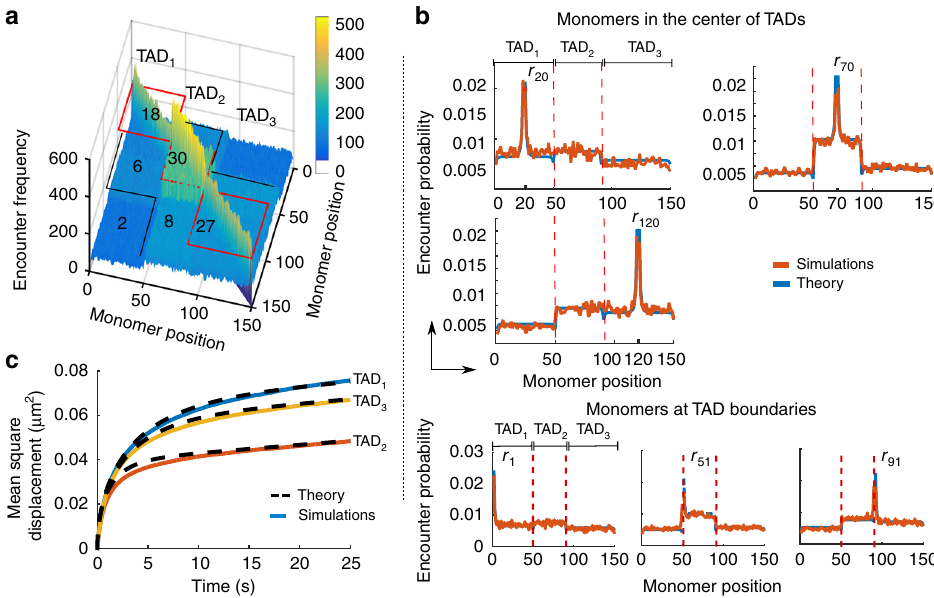
Fig. 1 Statistical properties of the heterogeneous RCL polymer. a Encounter frequency matrix of a polymer with three TAD blocks (TAD 1 , TAD 2 , TAD 3 ) of N = 50, N = 40, N = 60 monomers, computed from 10,000 simulations of Eq. (17) with Δ t = 0.01 s, D = 8 × 10 − 3 μ m 2 /s, d = 3, b = 0.2 μ m 1 . The 1 2 3 number of added connectors appears in each block. Three distinct diagonal TADs are visible (red boxes) where secondary structure appears (black lines) due to weak inter-TAD connectivity. b Encounter probability (EP) of the heterogeneous RCL described in panel ( a ), where the simulated (orange) and theoretical (blue, Eqs. (3) and (5)) EP agree. In the upper panel, we plotted the EP for middle monomers in each TAD: monomer r 20 (upper left), monomer r r 70 (top right), and monomer 120 (bottom left). In the bottom panel, we plotted the simulated (orange) vs. theoretical EPs (blue) for monomers (center), and r 91 (right), located at TAD boundaries. c Average mean-square displacement of monomers in each TAD of the heterogeneous RCL polymer, simulated as described in panel ( a ), simulations (continuous) vs. theory (dashed, Eq. (7)) until t = 25